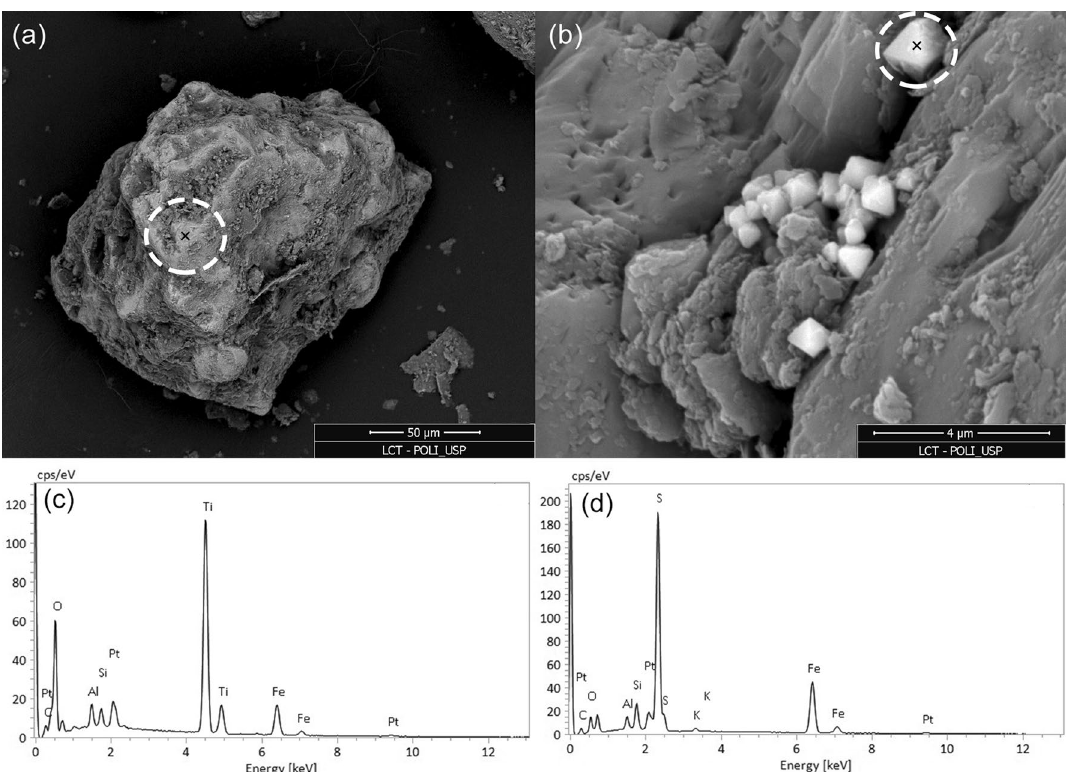
Figure 4. SEM image of sample from the contaminated zone at the water table fluctuation zone ( a ) SD 35 at 3.88 m and ( c ) SD34 at 3.9 m. The EDS analysis of ( a ) corresponds to the octahedral prism-shaped grains seen in ( b ), which was identified as an iron sulfide mineral, and the EDS analysis presented in ( c ) corresponds to where iron–titanium is identified ( d ). The “X” inside the circles indicates the location of the EDS